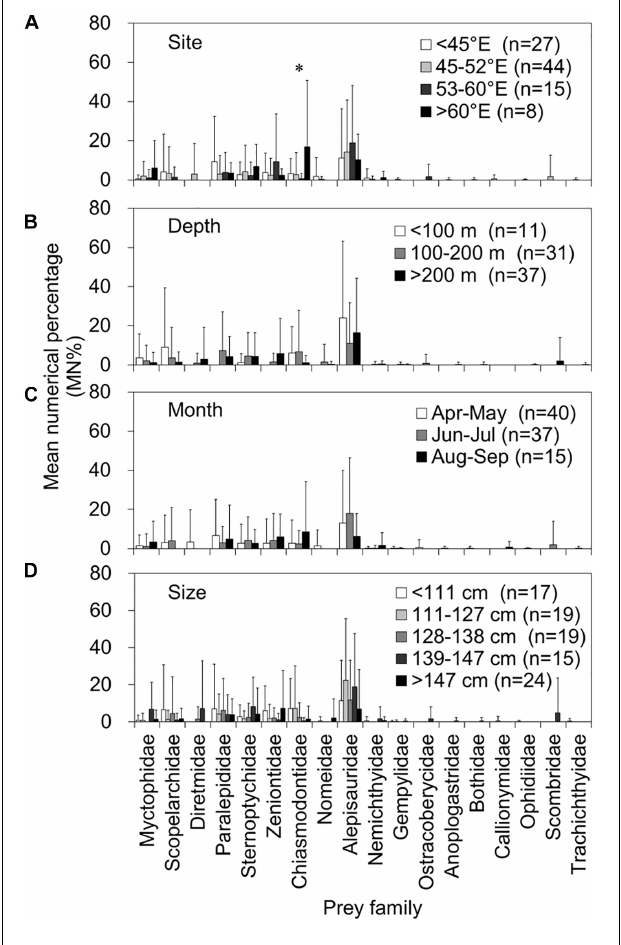
FIGURE 5 | Mean numerical percentage (MN%) and standard deviations (vertical lines) of the prey item by prey family in 94 fish remain-containing stomachs of bigeye tuna ( Thunnus obesus ) by (A) capture site, (B) depth, (C) month, and (D) fish size. The asterisks indicate levels of significance: *0.05.